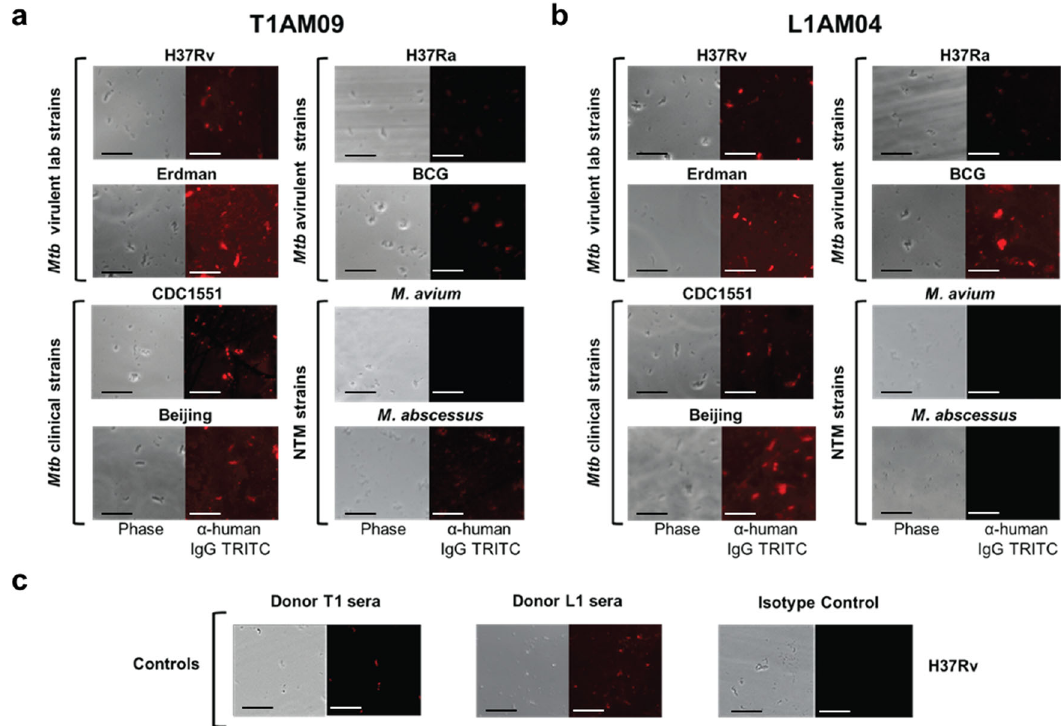
Fig. 6 T1AM09 and L1AM04 show distinct binding to mycobacterial strains by immuno fl uorescence (mycobacteria were grown without detergent to preserve the capsule). Binding of human IgG1 mAbs (10 µ g/mL) and polyclonal serum IgG (1:100 dilution) to virulent laboratory (H37Rv and Erdman) and clinical strains (CDC1551 and Beijing) of Mtb , avirulent strains of the Mtb complex group (H37Ra and BCG Pasteur) and nontuberculous mycobacteria ( M. avium and M. abscessus ) for a T1AM09; b L1AM04; and c Binding of positive (sera from T1 and L1) and negative (isotype-matched mAb to a fl avivirus) controls to H37Rv. Scale bar represents 10 µ